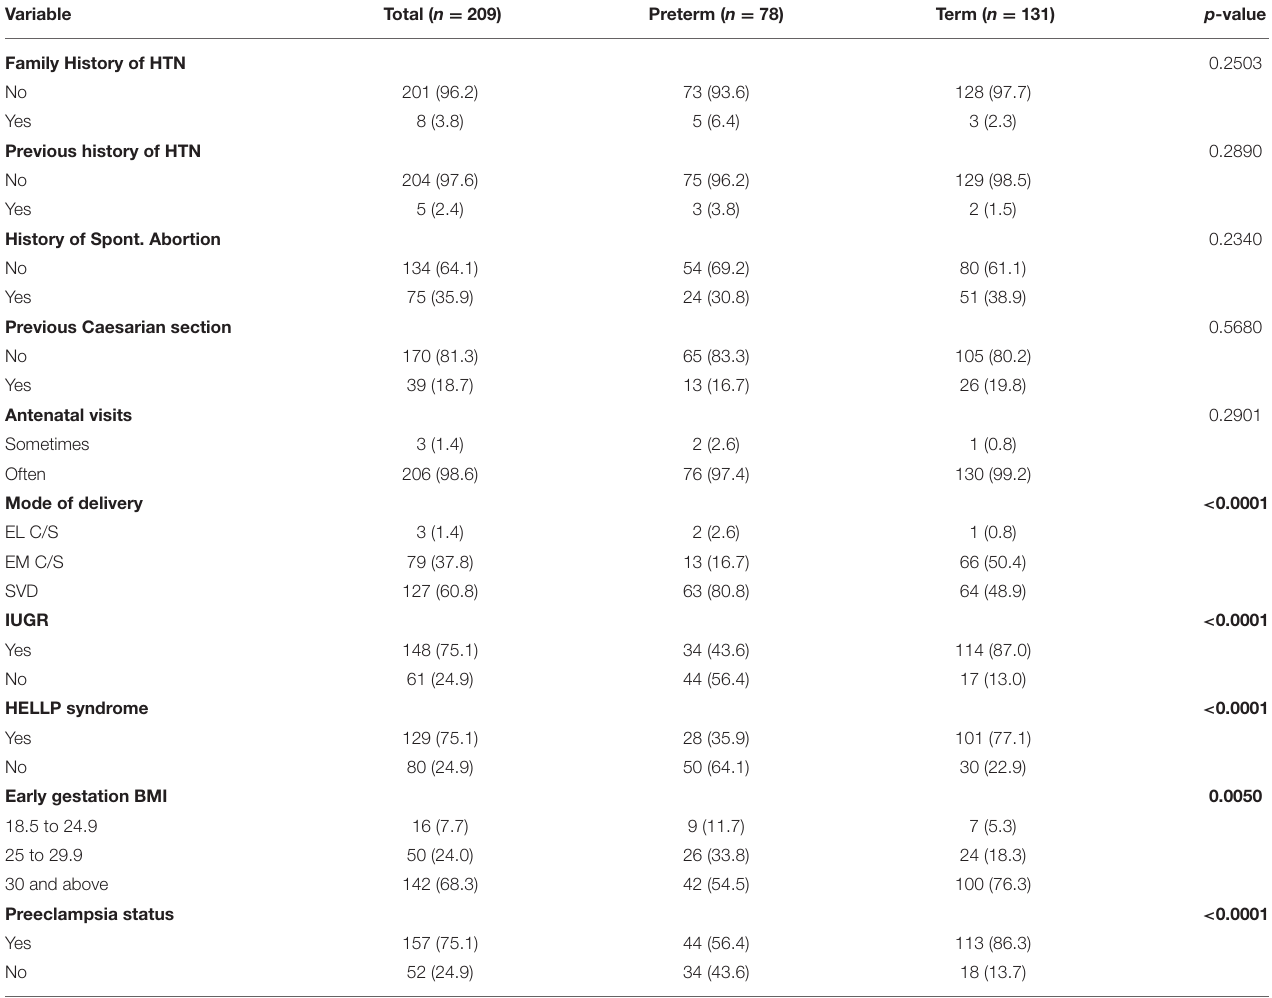
TABLE 2 | Association of preterm birth with clinical and perinatal factors among pregnant women.